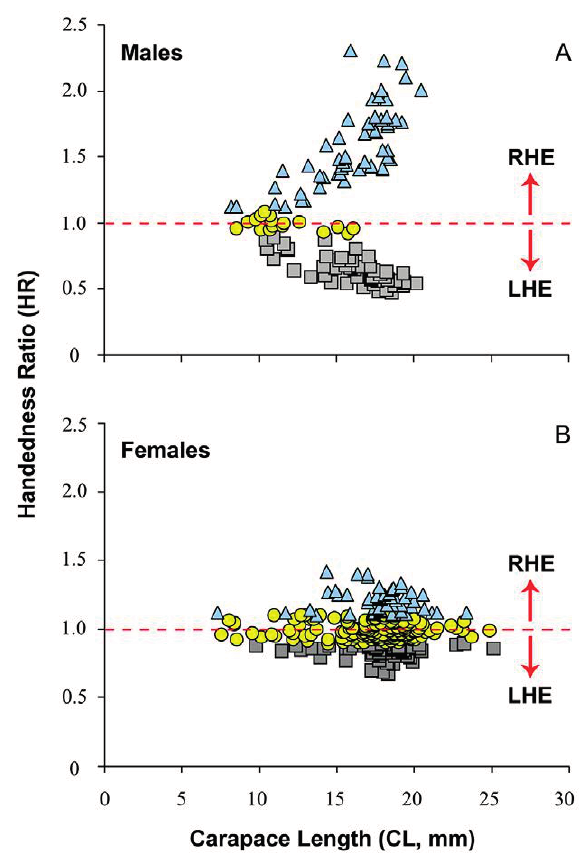
Fig. 5. – Handedness rate (HR) between chelipeds related to cara- pace length (CL), expressed in three chelar types in males (A) and females (B). HO, homochelous (circles); RHE, right heterochelous (triangles); and LHE, left heterochelous